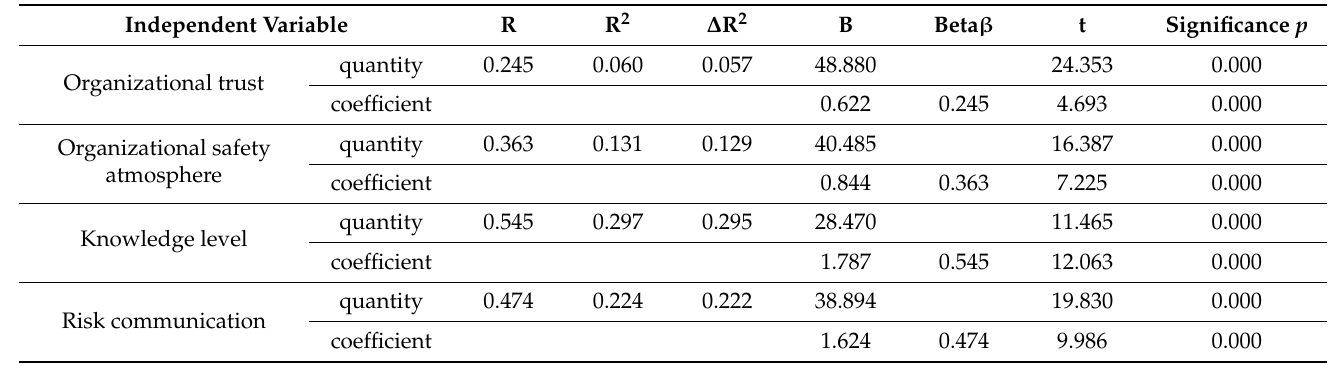
Table 4. Summary table of regression analysis model coefficients at various levels of influencing